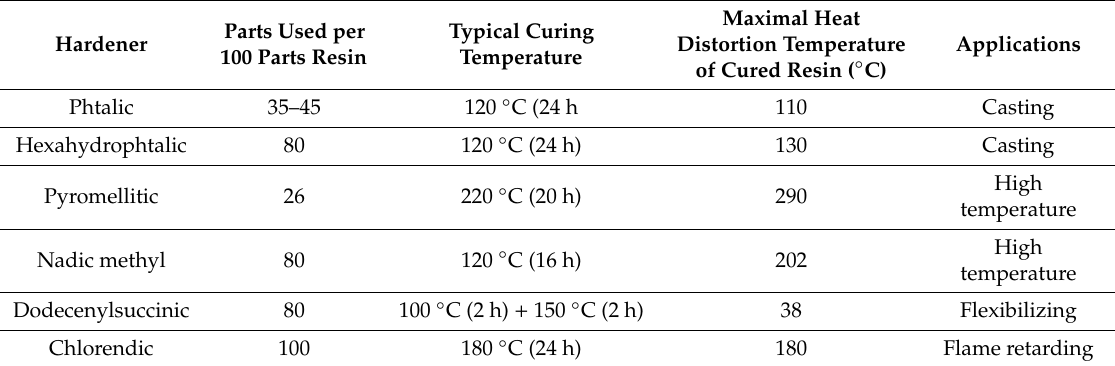
Table 3. Characteristics of anhydride hardeners used in low-molecular-weight bisphenol A-based epoxy resins, adapted from